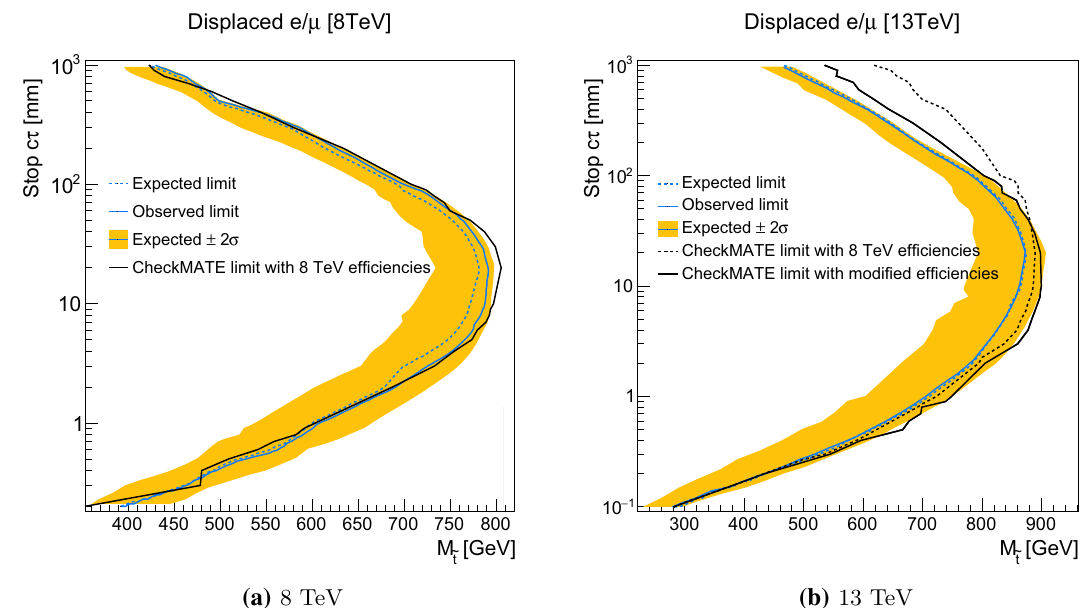
Fig. 1 A Comparison of the exclusion limits on the Displaced Lepton search provided by CMS with those obtained from CheckMATE (left: 8 TeV, 19.7 fb − 1 ; right: 13 TeV, 2.6 fb − 1 )